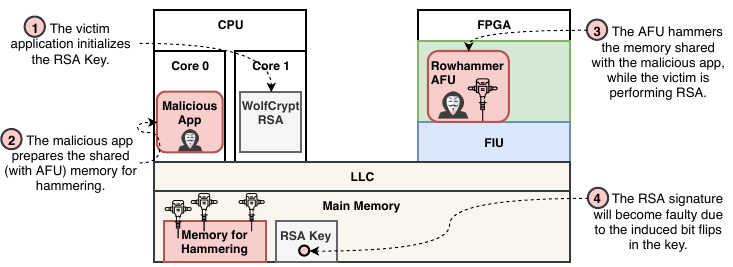
Figure 9: WolfSSL RSA Fault Injection